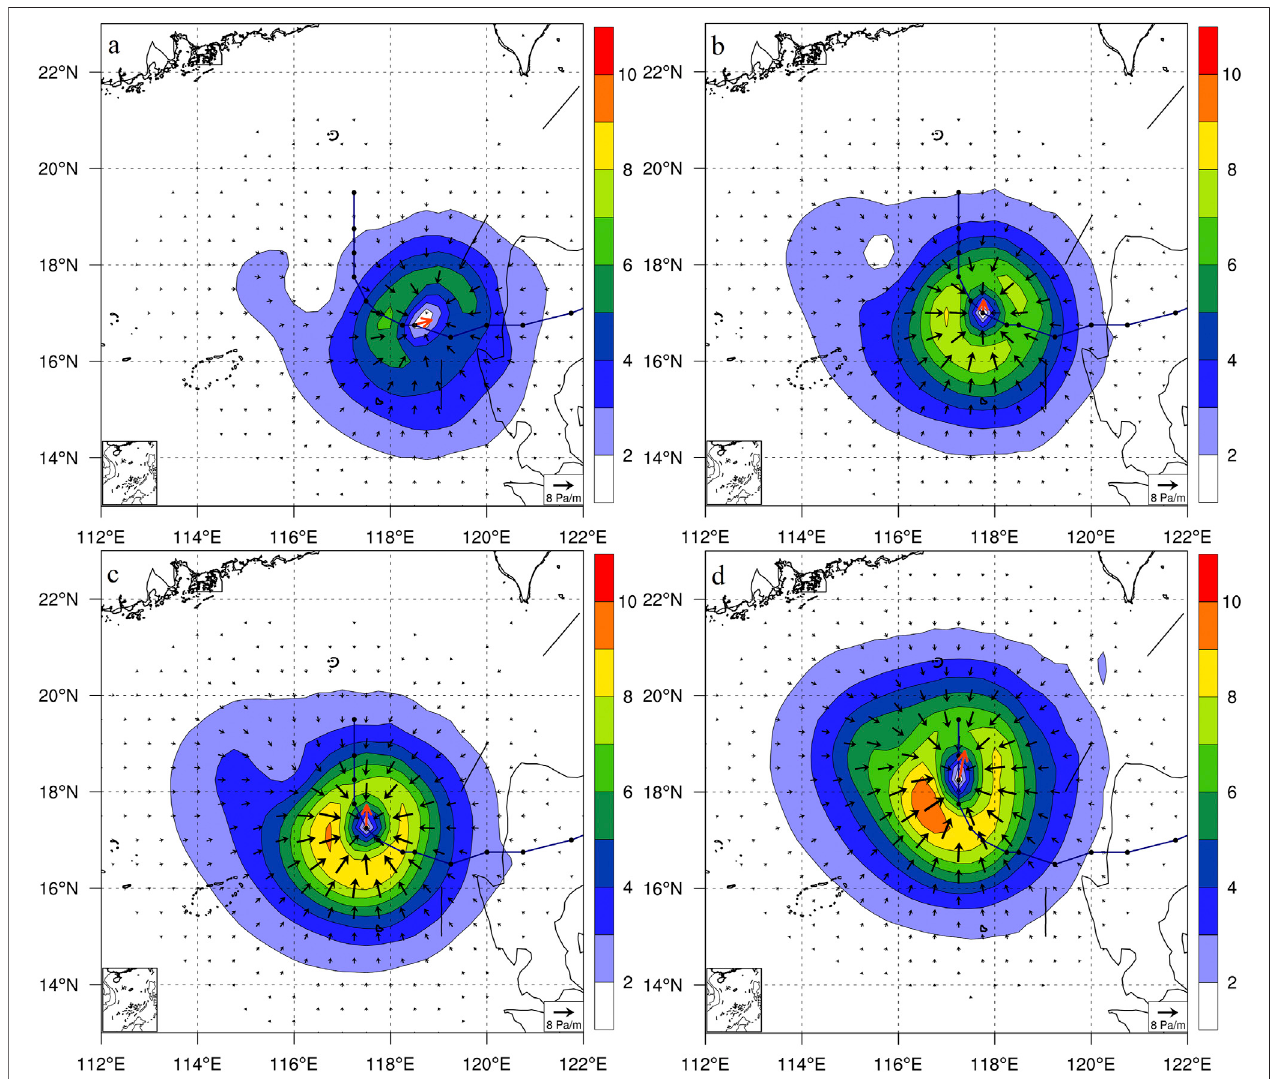
FIGURE 7 | The averaged horizontal pressure gradient force between 975- and 300-hPa at different stages Unit: Pa m − 1 . (A) T-18, (B) T-6, (C) T, (D) T+12. (Shaded contours and black vectors represent the magnitude and direction of averaged pressure gradient force, respectively. Red vector denotes the composite pressure gradient force on grids in a circle with a radius of 400 km from the TC